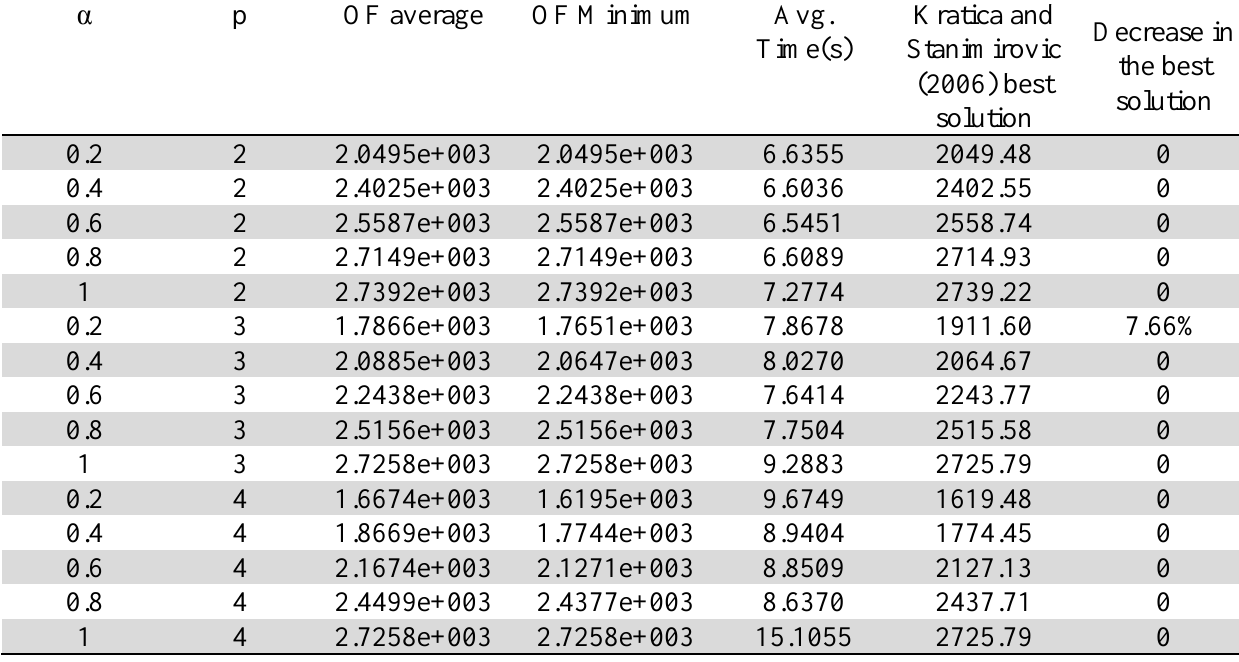
Results of the GA for different CAB data set